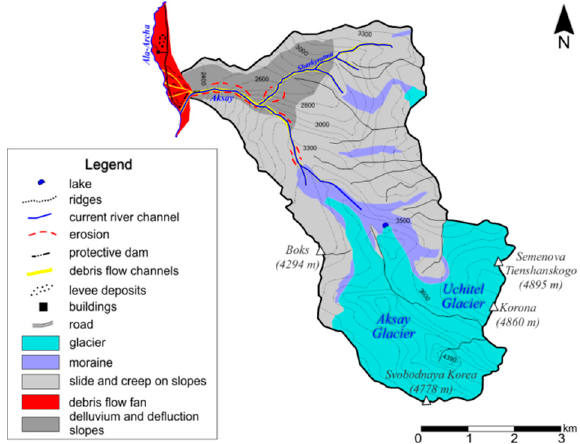
Figure 6. Geomorphologic map of the Aksay Basin.